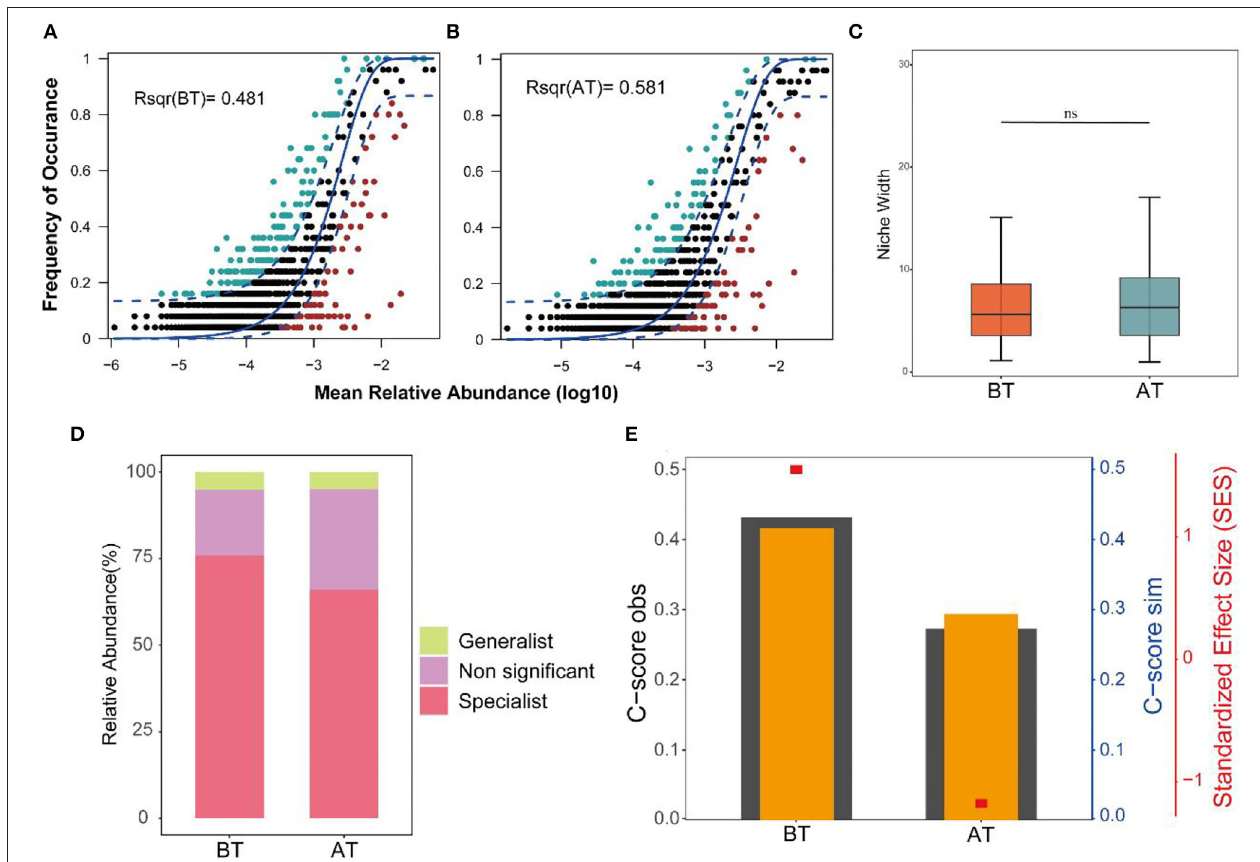
FIGURE 3 | Ecological processes shaping the gut community assembly in BT and AT patients. (A,B) Predicted frequency of occurrence of gut microbiota in the BT group (A) and AT group (B) . The solid blue line is the best fit to the neutral community model (NCM), and the dashed blue line expresses 95% confidence intervals around the NCM prediction. ASVs that occur more or less frequently than predicted by the NCM are shown in lightgreen and lightred, respectively. R 2 indicate the fit to this model. (C) Boxplot shows the niche width index distribution of microbial community of gut in BT and AT samples. (D) Relative contributions of generalized and specialized species to BT group and AT group of intestinal microbiotas. (E) C-score metric using null models. The values of observed C-score (C-score obs ) > simulated C-score (C-score sim ) represent non-random co-occurrence patterns. ns, no